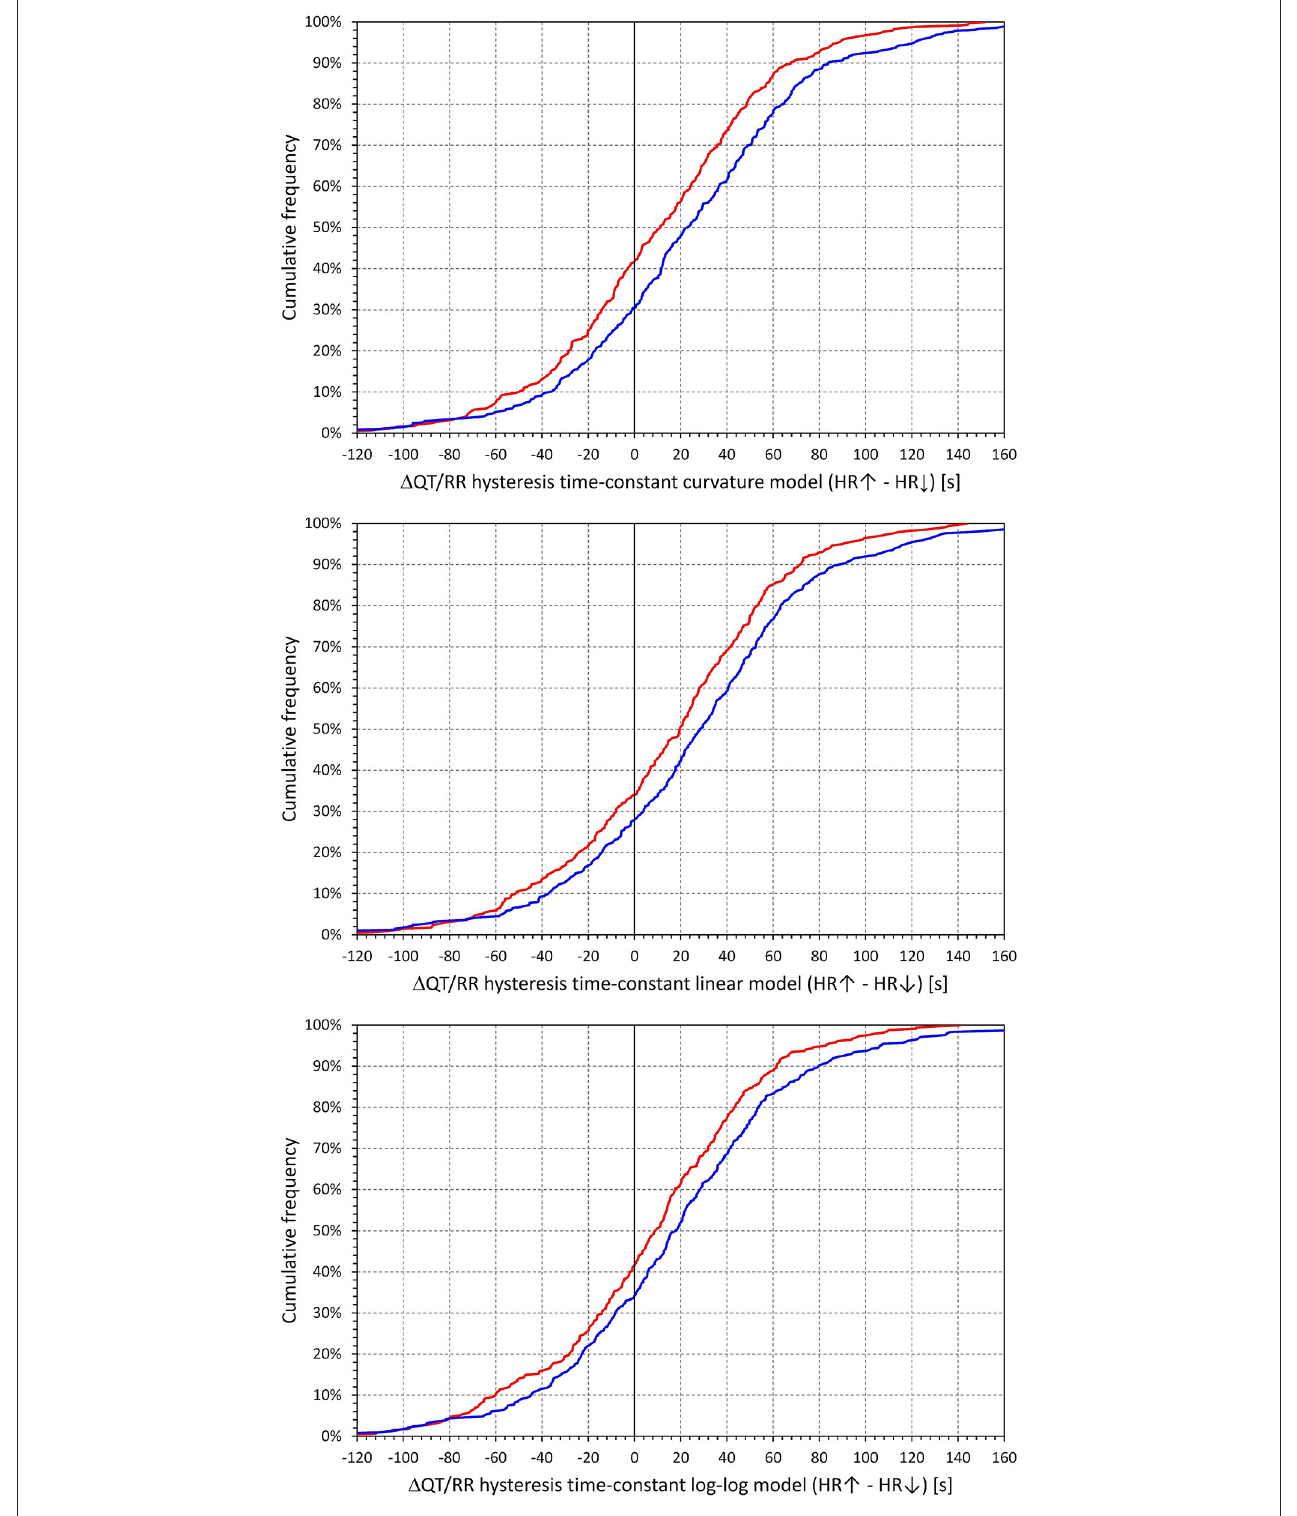
FIGURE 11 | Cumulative densities of subject-specific differences among hysteresis time constants during heart rate acceleration and deceleration. The top, middle, and bottom panels show the differences for the curvature, linear, and log-log QT/RRH models, respectively. In each panel, the red and blue lines correspond to females and males,